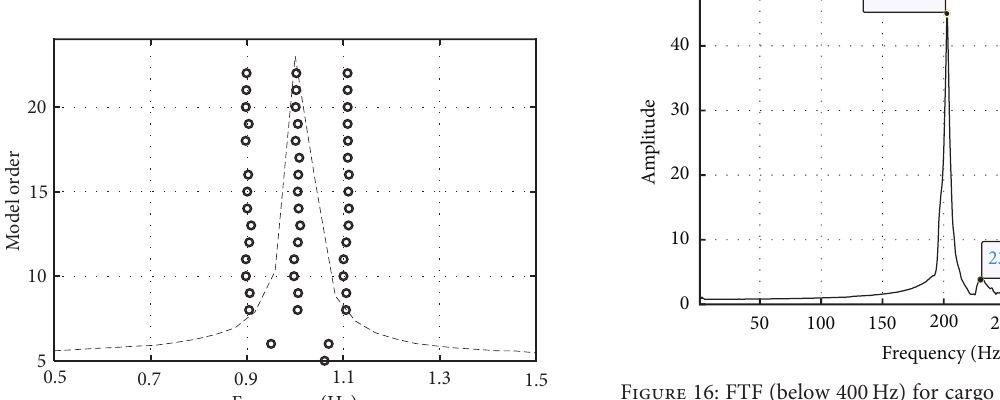
Figure 13: The distribution of identified frequency-damping with model order from 4 to 22.